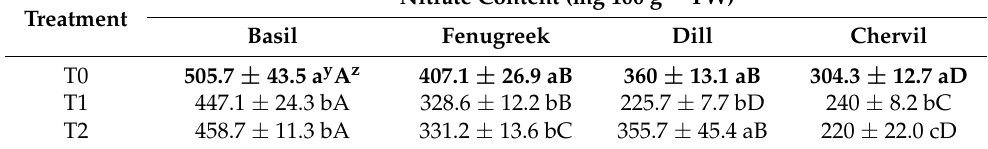
Table 3. Nitrate content (mg100 g − 1 fresh weight (FW)) of basil, fenugreek, dill, and chervil micro- greens cultivated under three light-emitting diode (LED) lamp spectra. The best light treatment, for each plant species, is bold.